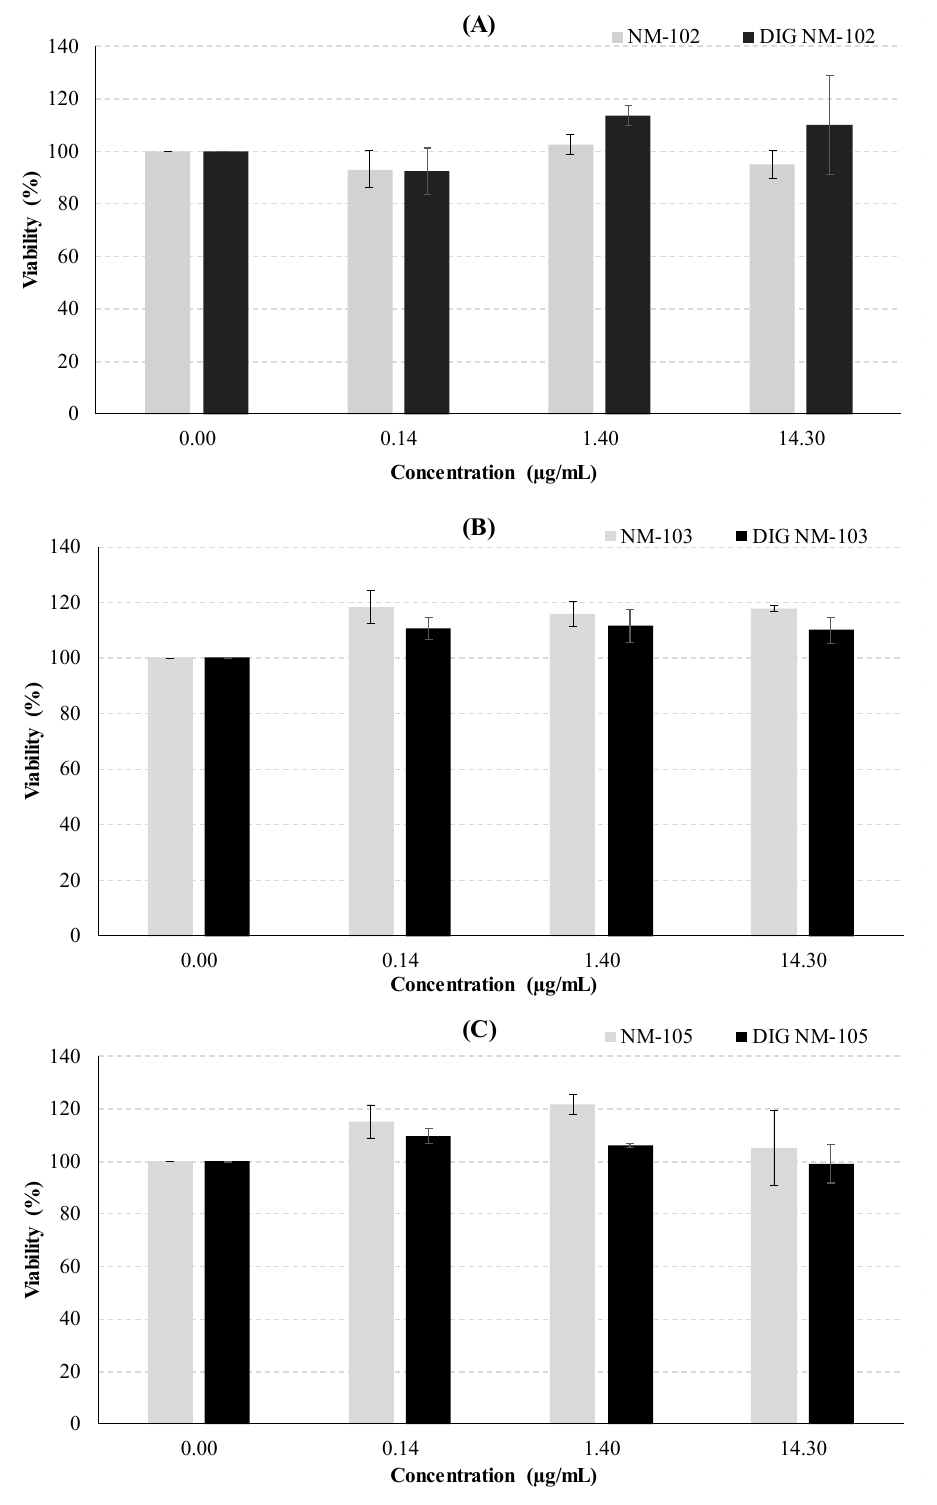
Figure 4. Analysis of the cytotoxic e ff ects in Caco-2 cells, 24 h after exposure to the undigested and digested (DIG) NMs: ( A ) NM-102, ( B ) NM-103 and ( C ) NM-105.